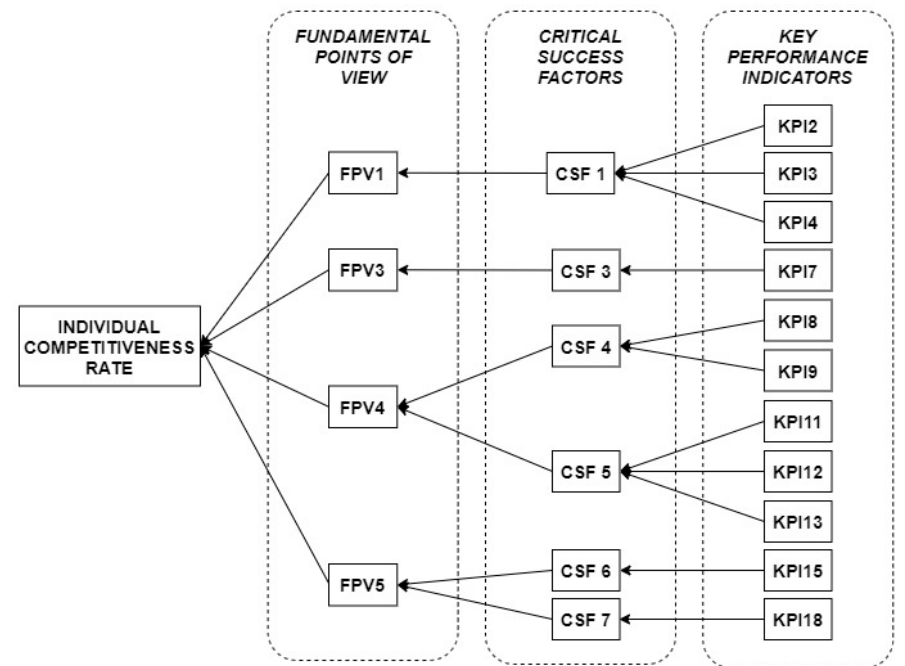
Figure 6. Optimized competitiveness measurement model.